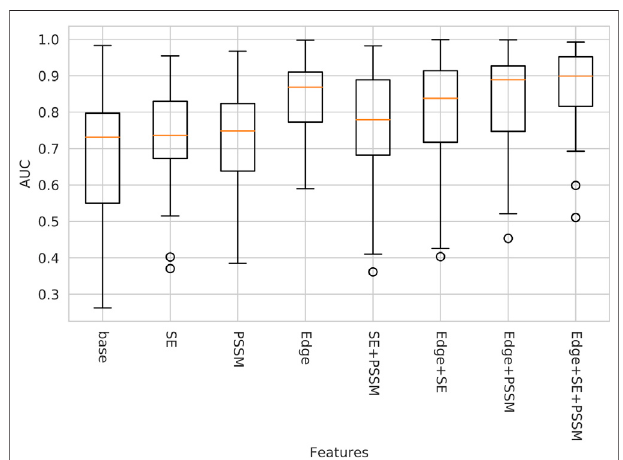
FIGURE2| AUConvalidationdatausingdifferentsubsetsofallfeatures. Edge denotes the edge identities, and the lack of the Edge features means that only proximity is considered. PSSM denotes the position speci fi c scoring matrix. SE denotes